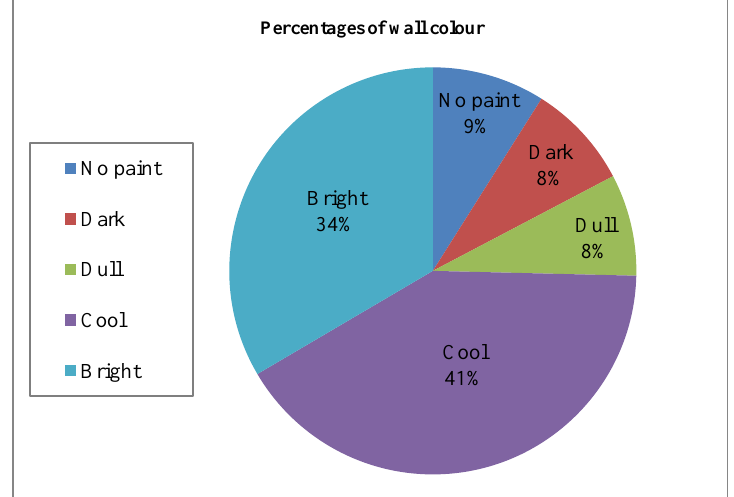
Figure 5. Percentages of wall colour in the study